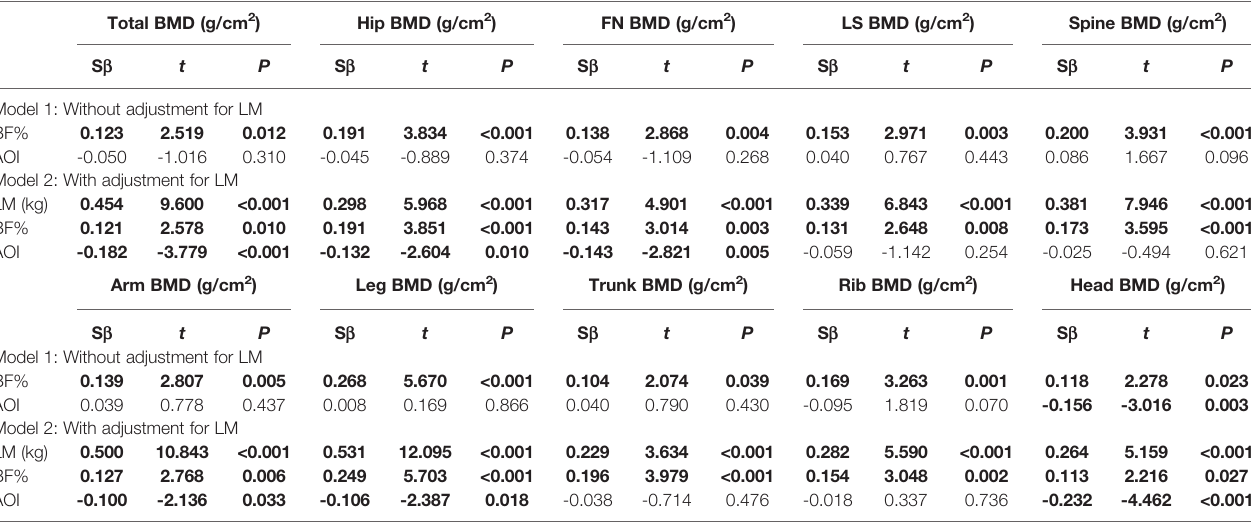
TABLE 5 | Regression analysis of BF%, AOI, and LM with total body and regional